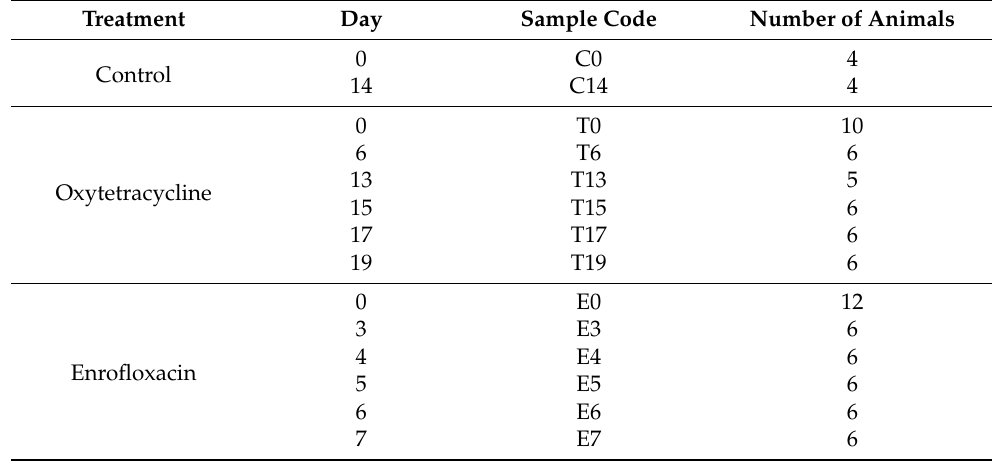
Table 1. Number of animals sampled for each treatment